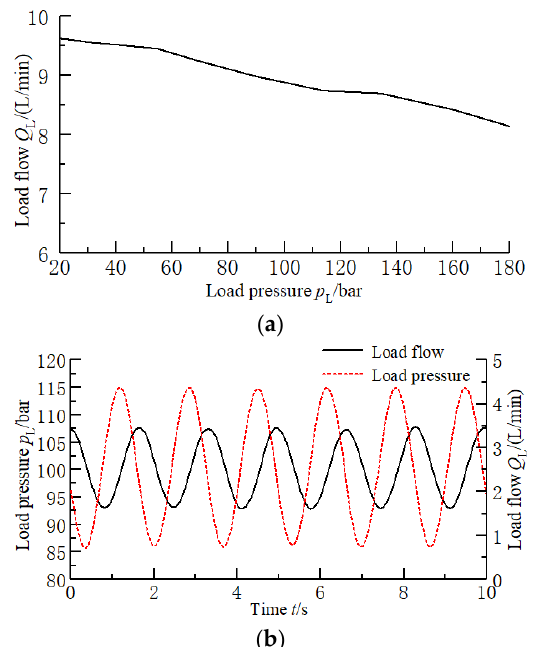
Figure 10. Simulation diagram of system pressure and flow coupling characteristics: ( a ) Simulation diagram of influence of system pressure on flow; and ( b ) simulation diagram of the effect of system flow on pressure disturbance.